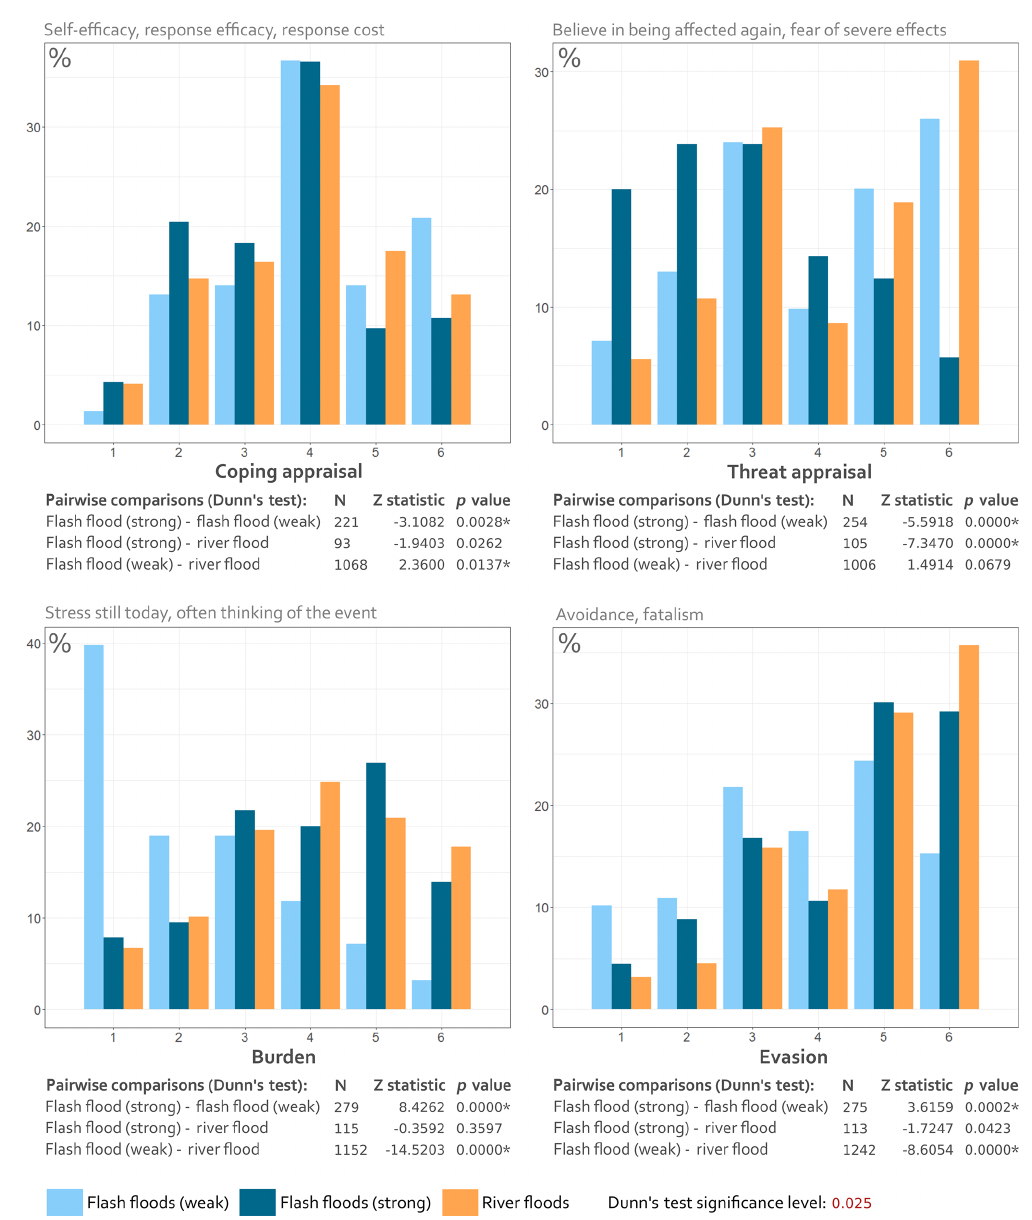
Figure 2. Relative distributions of the combined psychological indicators for each flood type and Dunn’s test results. The results of the Dunn test reveal the direction shift of each distribution compared to the other distributions (negative means a shift towards lower values, positive a shift towards higher values) by also indicating the strength and significance of the shift ( Z statistic and p